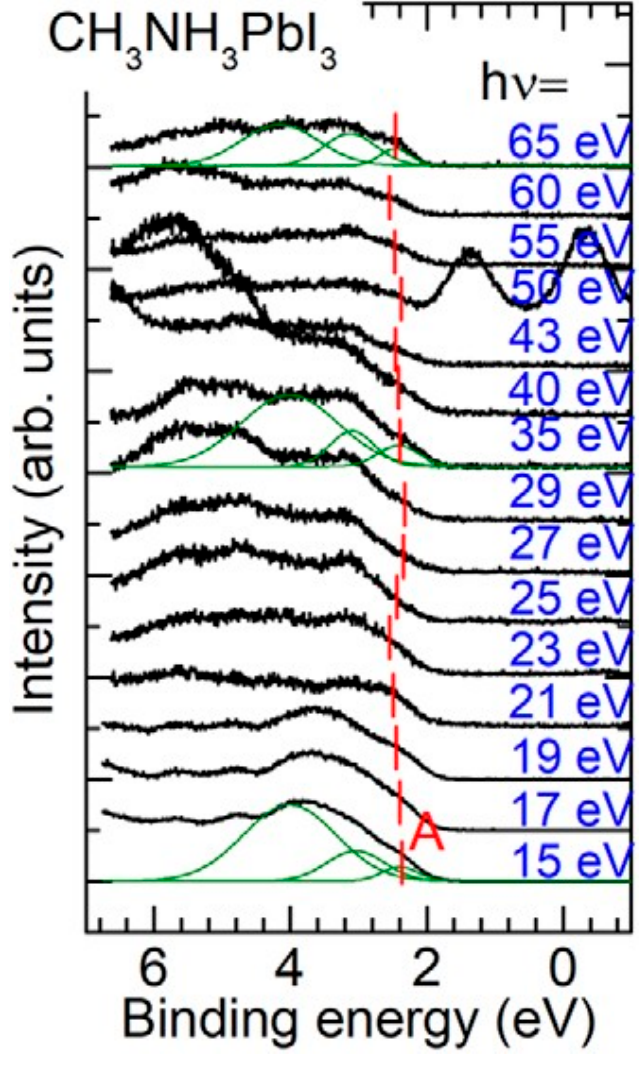
Figure 16. (Color online) Photon energy h ν dependence of angle-resolved photoemission spectroscopy with synchrotron radiation (SR-ARPES) spectra along the surface normal direction for cleaved MAPbI 3 single crystal surface. The binding energy is referred to the Fermi level position. From Ref. [120] with permission.